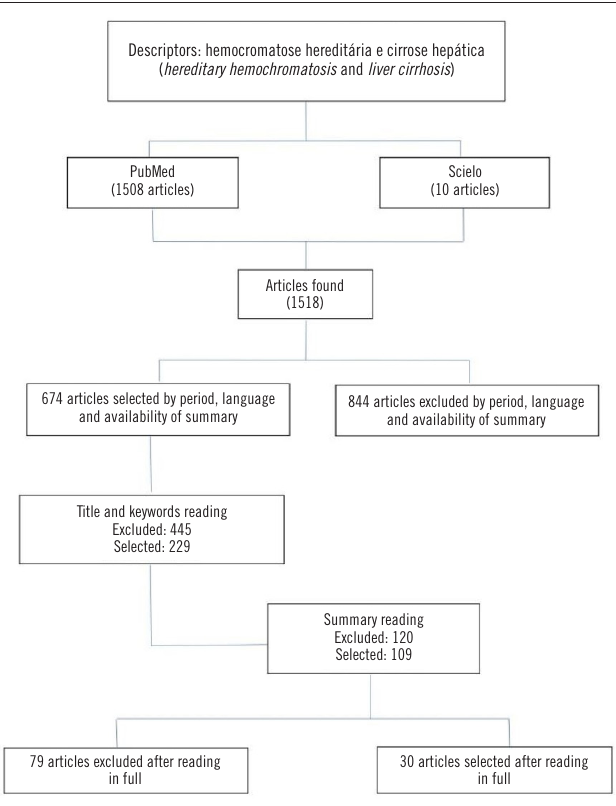
FIGURE 1 – Flowchart of articles inclusion and exclusion